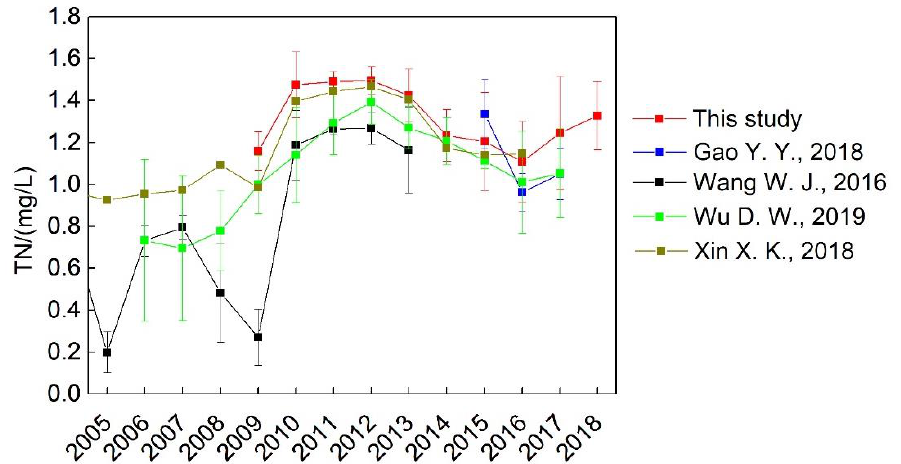
Figure 4. Comparative analyses of TN concentrations in the Danjiangkou Reservoir from 2005 – 2018.